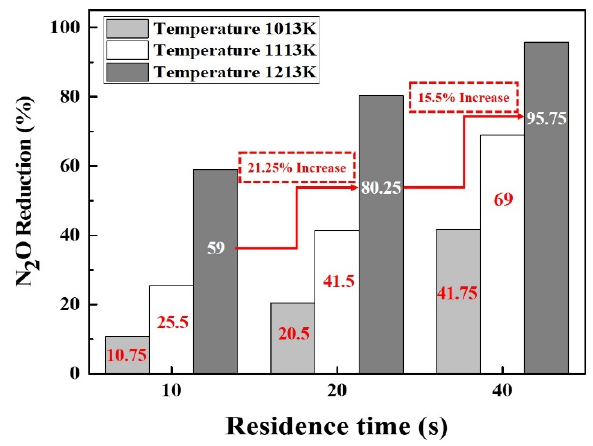
Figure 5. Dependence of N 2 O reduction on the residence time .